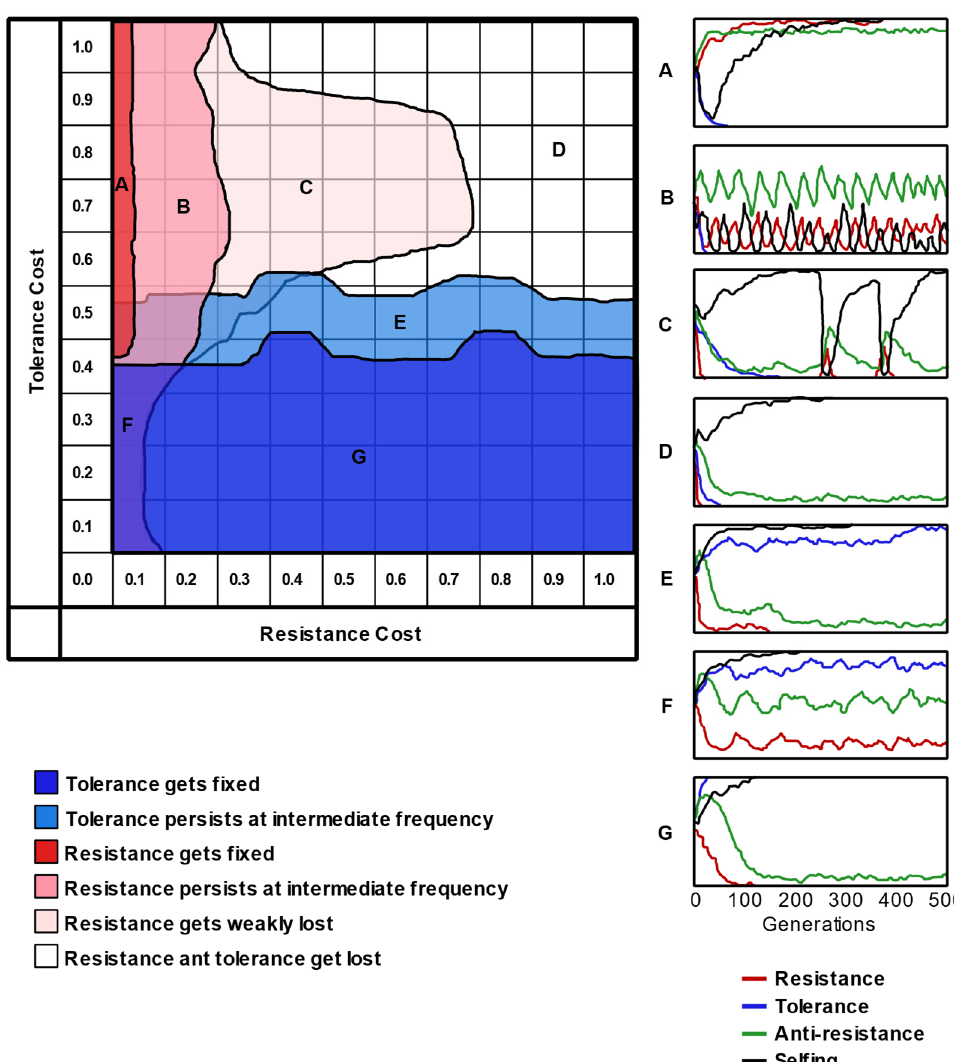
Figure 3. Zones of the parametric space of the resistance and tolerance costs/benefits. As previously, the tolerance benefit was equal to 1- c t . This division resulted from the analyses that are also displayed in Supplementary Figure S1. Most of the zones were common to all four sets of simulations (two types of selfing × two models), and they differed only in the extent of the area that they occupied. On the right, examples of simulations corresponding to each zone are presented, showing the evolution of the frequencies (vertical scale) of resistance, tolerance, herbivores’ anti-resistance, and selfing over time (horizontal scale).